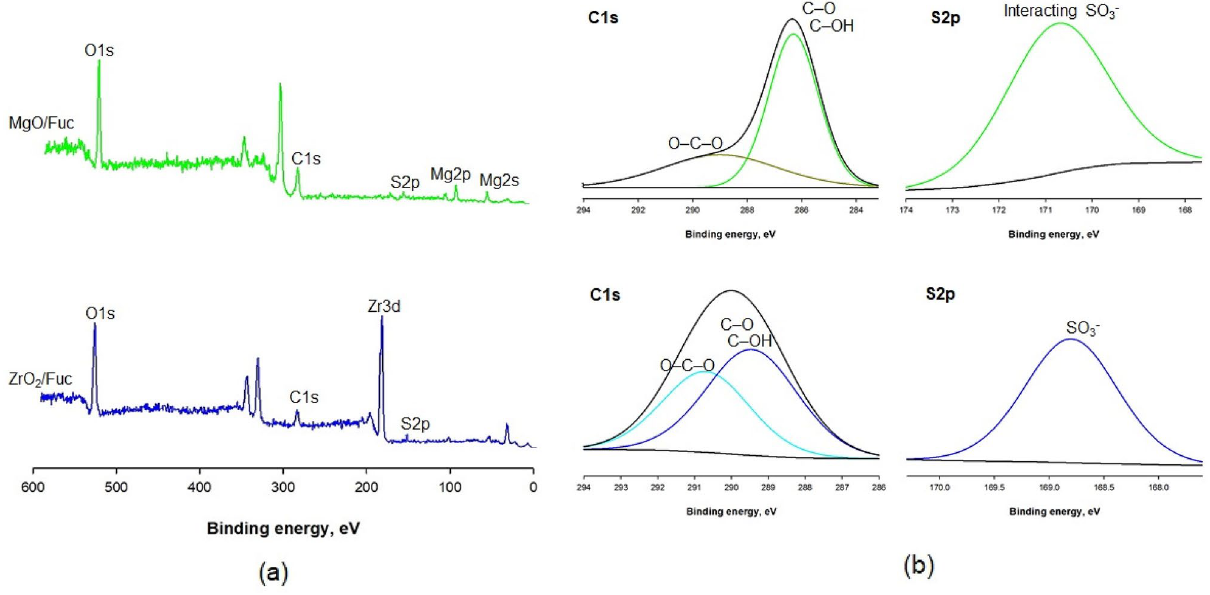
Figure 2. XPS survey spectra of MgO/Fuc and ZrO 2 /Fuc ( a ), and the deconvoluted XPS of C 1s for MgO/Fuc; S 2p for MgO/Fuc; C 1s for ZrO 2 /Fuc; and S 2p for ZrO 2 /Fuc ( b